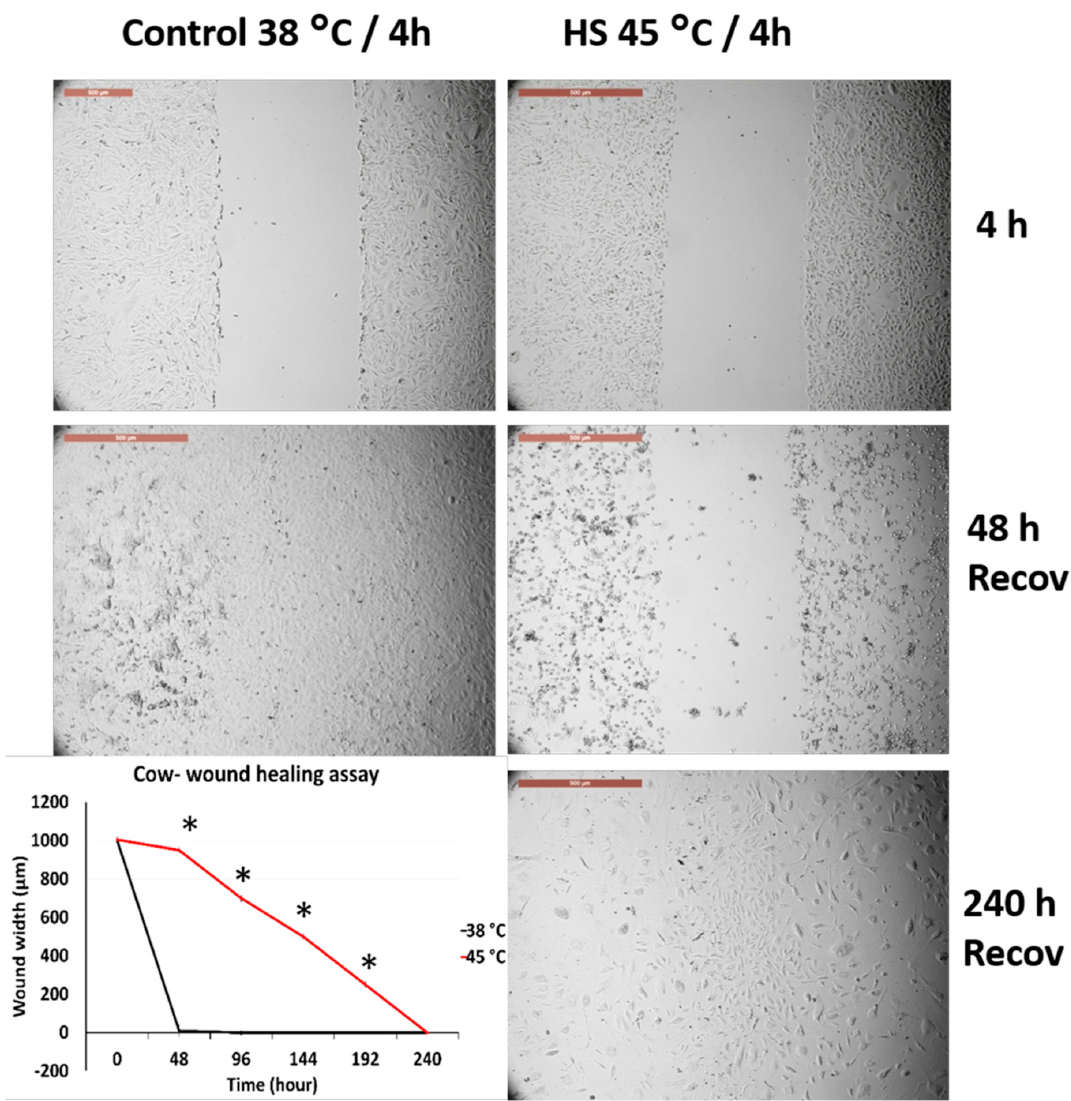
Figure 6. Wound healing (cell scratch) assay for cow first passage fibroblasts exposed to 45 °C for 4 h and control cells (38 °C for 4 h). Cells were incubated under the required conditions, recovered at 38 °C, and monitored daily for wound closure. Scale bar = 500 µm. Data are presented as means ± SEM, values of the same timings were analyzed using Student’s t -test, and asterisks (*) indicate significant differences at p < 0.05.